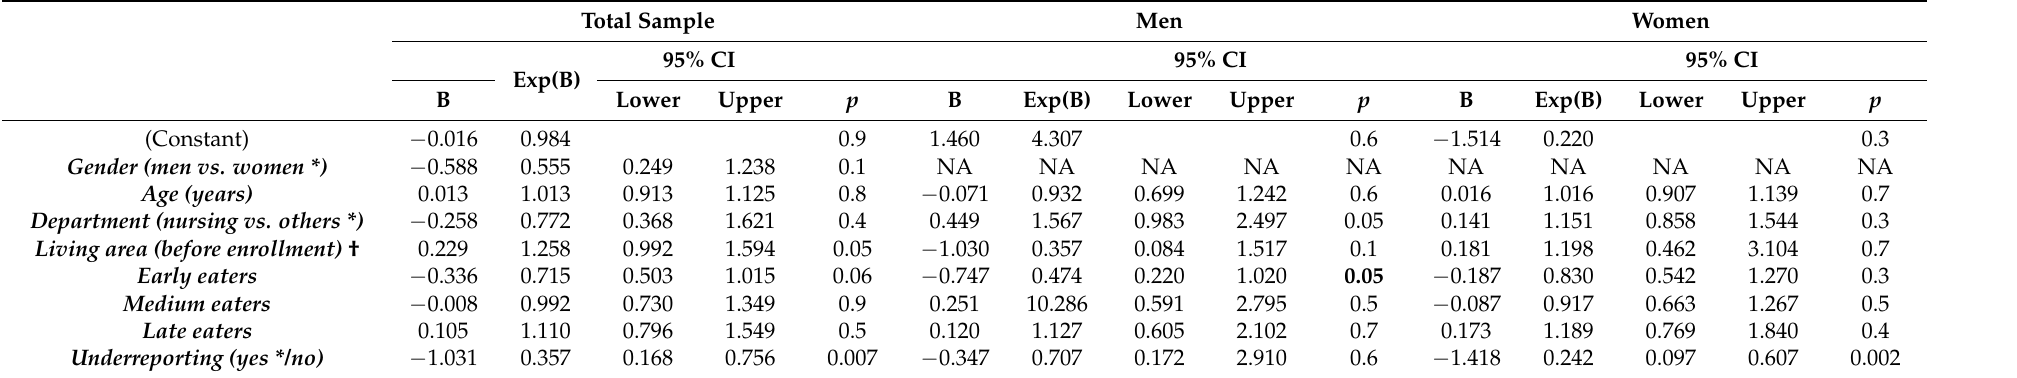
Table 6. Logistic regression analysis with overweight/obesity as the dependent variable and meal patterns as the independent variable in the total sample, men and women. Total Sample Men